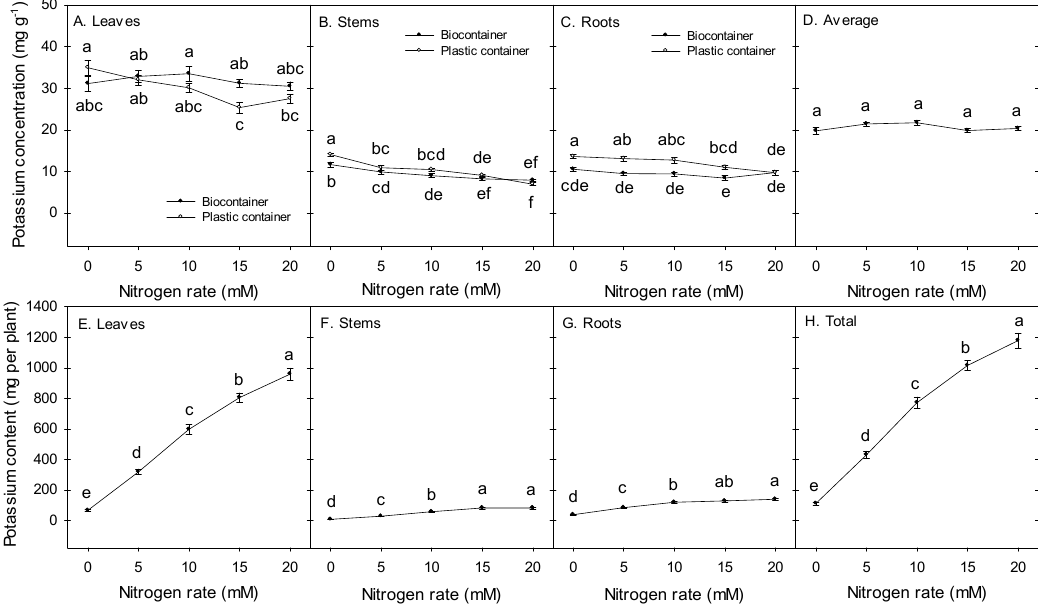
Figure 1. Concentrations (mg g − 1 ) and contents (mg per plant) of potassium (K) in leaves, stems, roots, or the entire plant of H. macrophylla ‘Merritt’s Supreme’ affected by the interaction between nitrogen (N) rate and container type ( A – C ) or by the main effect of N rate ( D – H ). Data points are means ( A – C ) across irrigation frequencies ( n = 10 ) and ( D – H ) across container types and irrigation frequencies ( n = 20 ) . Error bars are standard errors. Different lower-case letters within a chart indicate significance differences between means using Tukey’s HSD test at p -value ≤ 0.05.